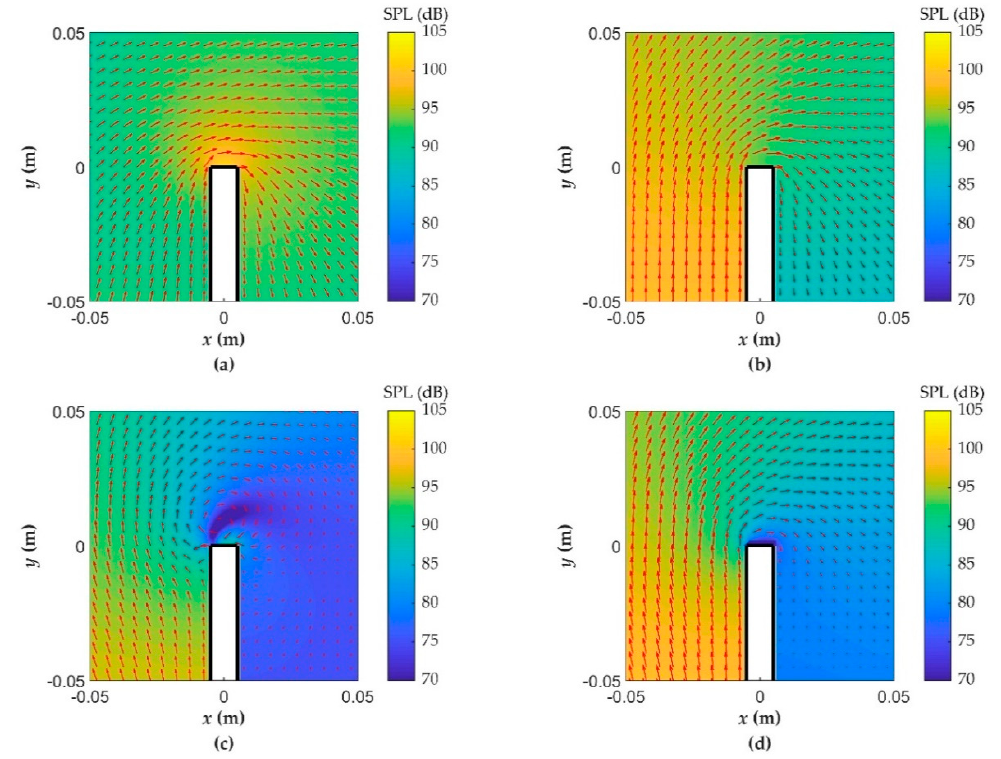
Figure 6. The SPL and sound intensity distribution at 500 Hz near the top edge of the barrier with ( a ) bad impedance ( β = 11.2j β 0 ), ( b ) rigid boundary ( β = 10 − 10 ), ( c ) good impedance ( β = 27.3j β 0 ) and ( d ) soft boundary ( β = 10 10 ).